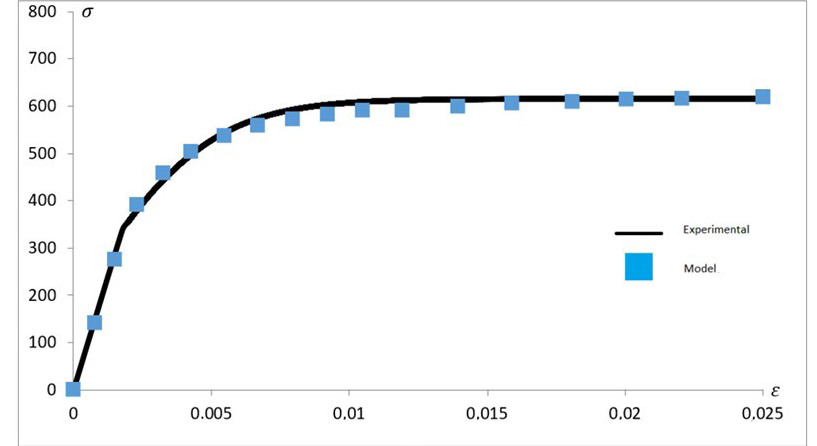
Figure 7. Comparative stress curve (MPa) - strain (mm / mm)- 5 1 2 2x10 s ε − − = . UNS S3180F51 duplex stainless steel.